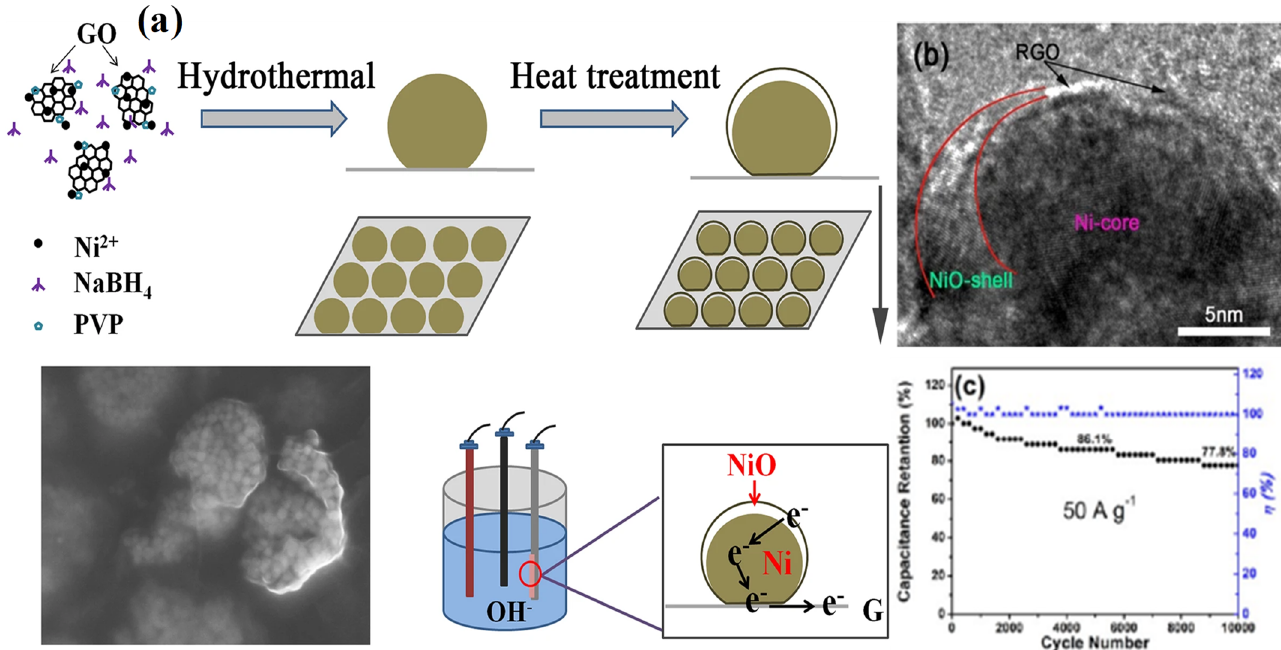
Figure 1. ( a ) Schematic representation of Conducive mechanism of material. ( b ) HRTEM micrographs of NiO/Ni/RGO. ( c ) Columbic efficiency at current rate of 50 A/g. Figure reprinted from ref. [46]. The Author(s) licensed under CC BY 4.0.